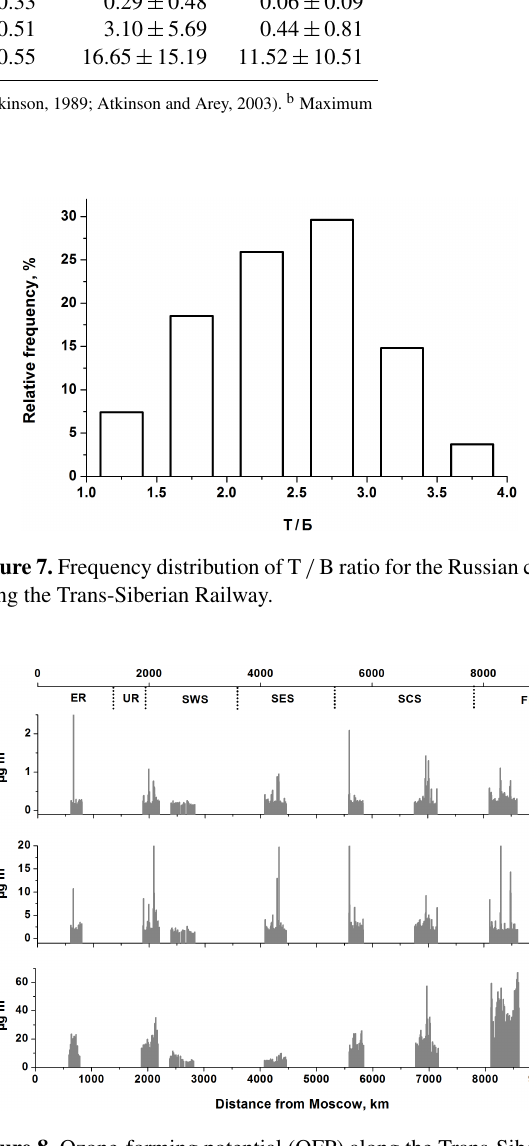
Figure 8. Ozone-forming potential (OFP) along the Trans-Siberian Railway from daytime measurements